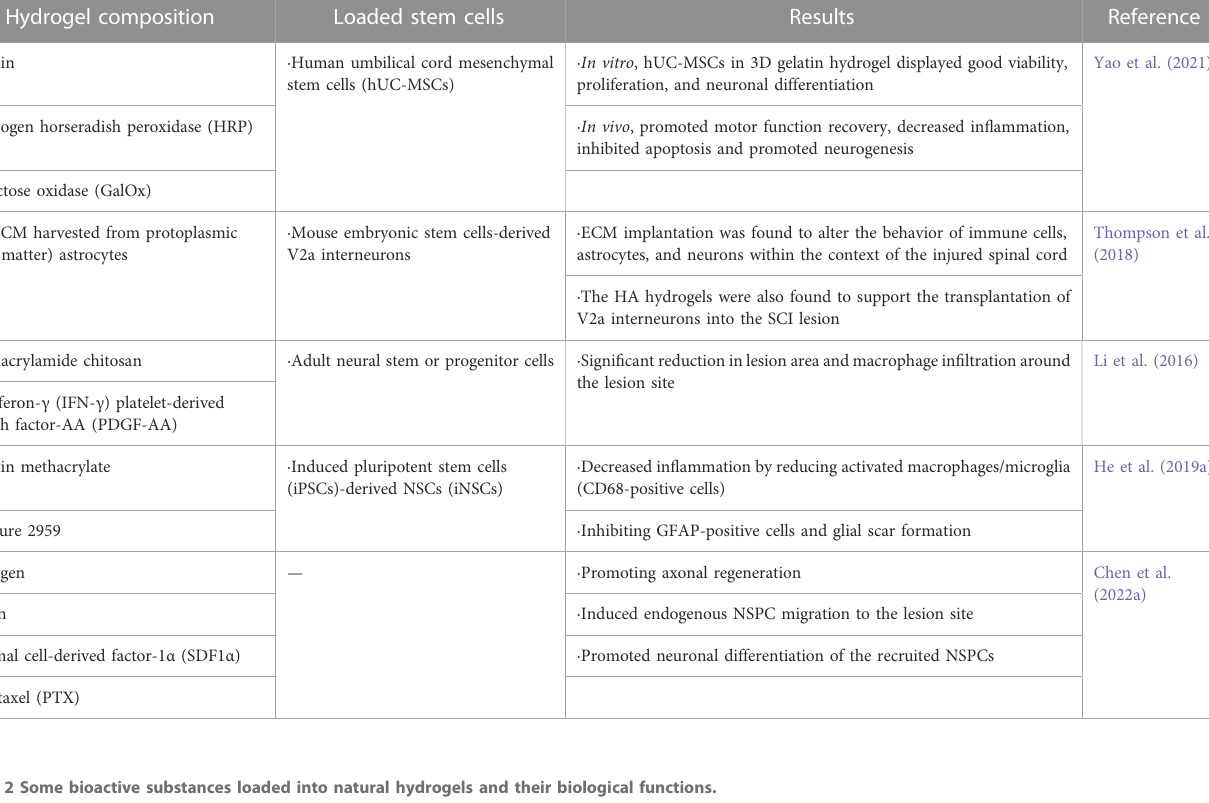
TABLE 2 Some bioactive substances loaded into natural hydrogels and their biological functions.